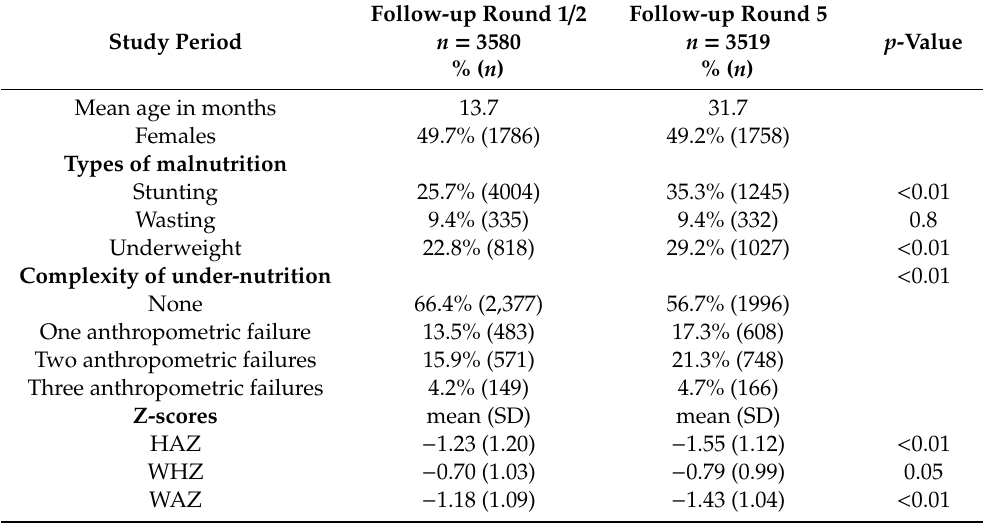
Table 1. Prevalence of malnutrition and population change in z-scores between first (follow-up Round 1 for Kratie and Ratanakiri and follow-up Round 2 for Phnom Penh) and last follow-up (follow-up Round